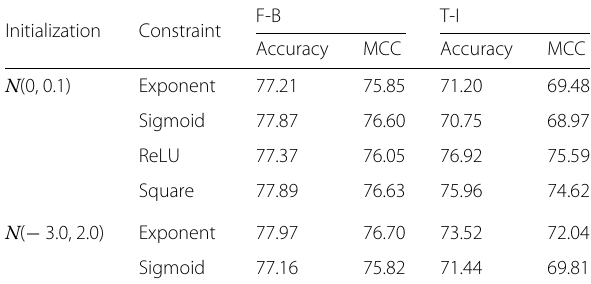
Table 2 Audio scene classification performance under